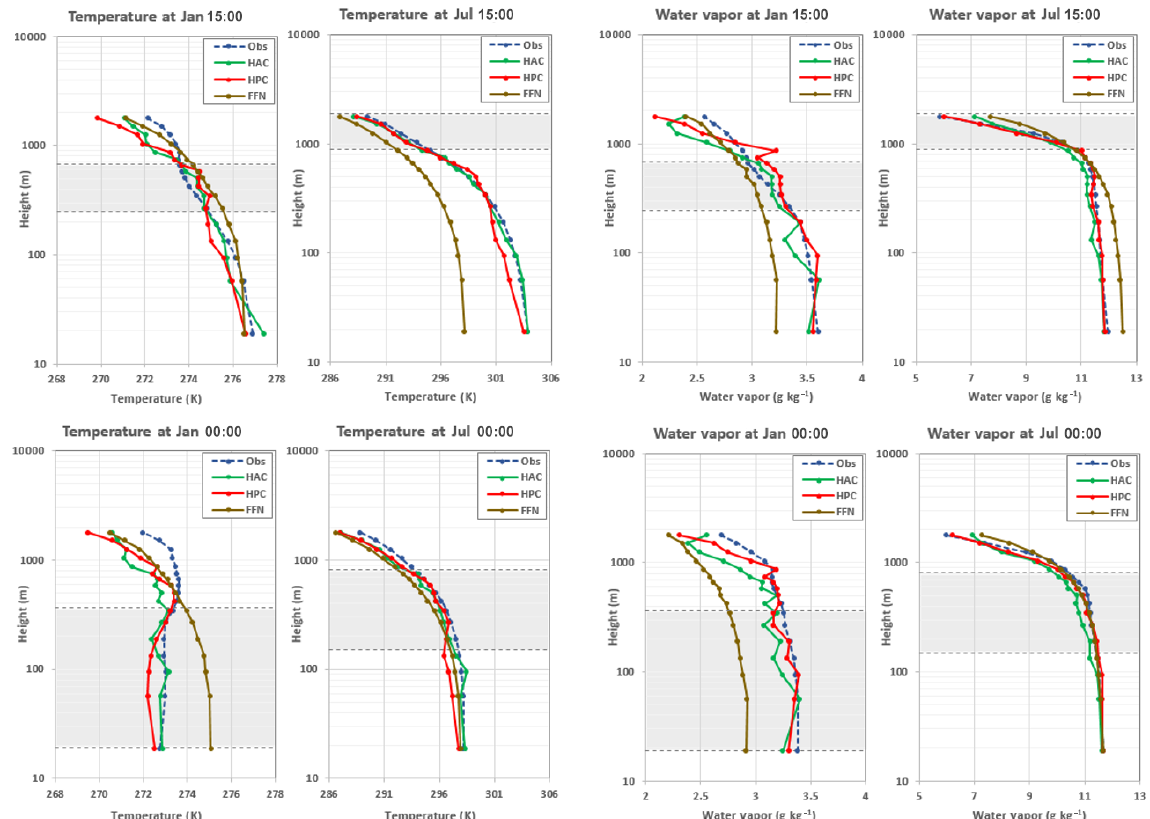
Figure 2. Temperature and water vapor mixing ratio from the observation and three DNN predictions: FFN, HPC, and HAC in January and July of 2005 at 15:00 and 00:00 local time of Logan, Kansas. The y axis uses a log scale. The training data are from the 3-hourly output of WRF from 1984 to 2003. The lower and upper dashed lines show the lowest and highest (5th and 95th percentile) PBL heights at that particular time. For example, the lowest PBL height is about 19m, while the highest PBL height is about 365m at 00:00 in